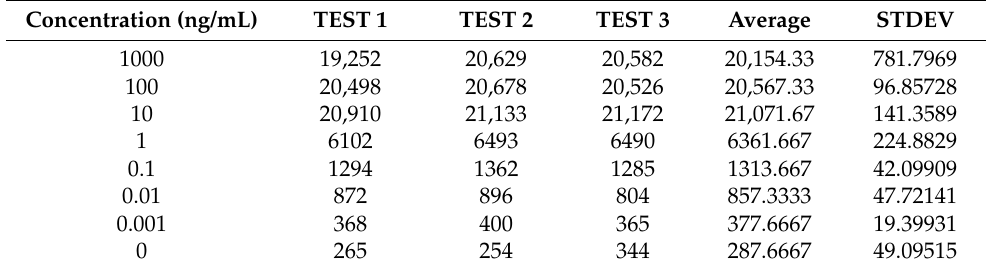
strips with different concentrations of COVID-19 N protein standard